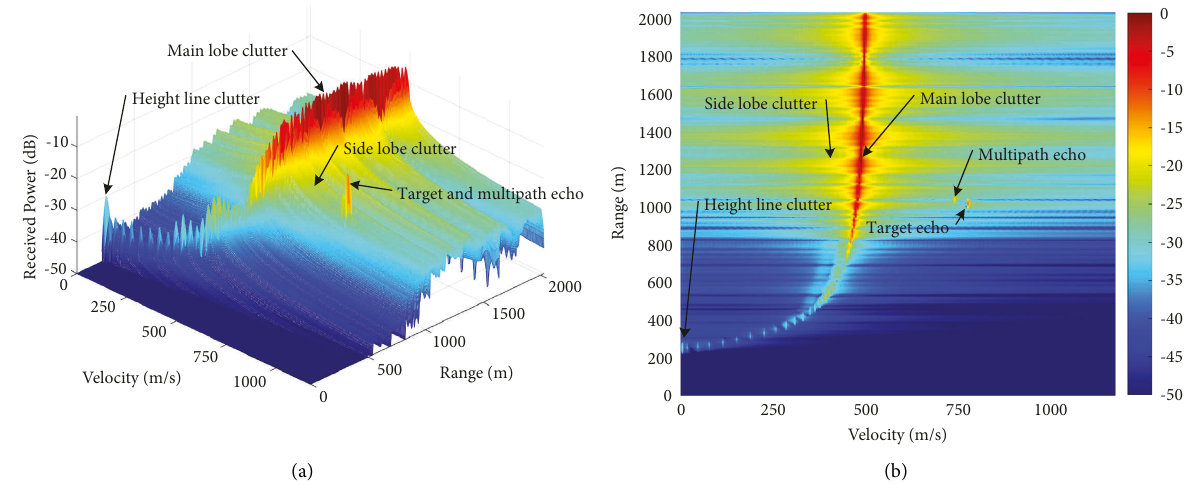
Figure 10: (a) The two-dimensional Range-Doppler diagram of the total echo; (b) top view.